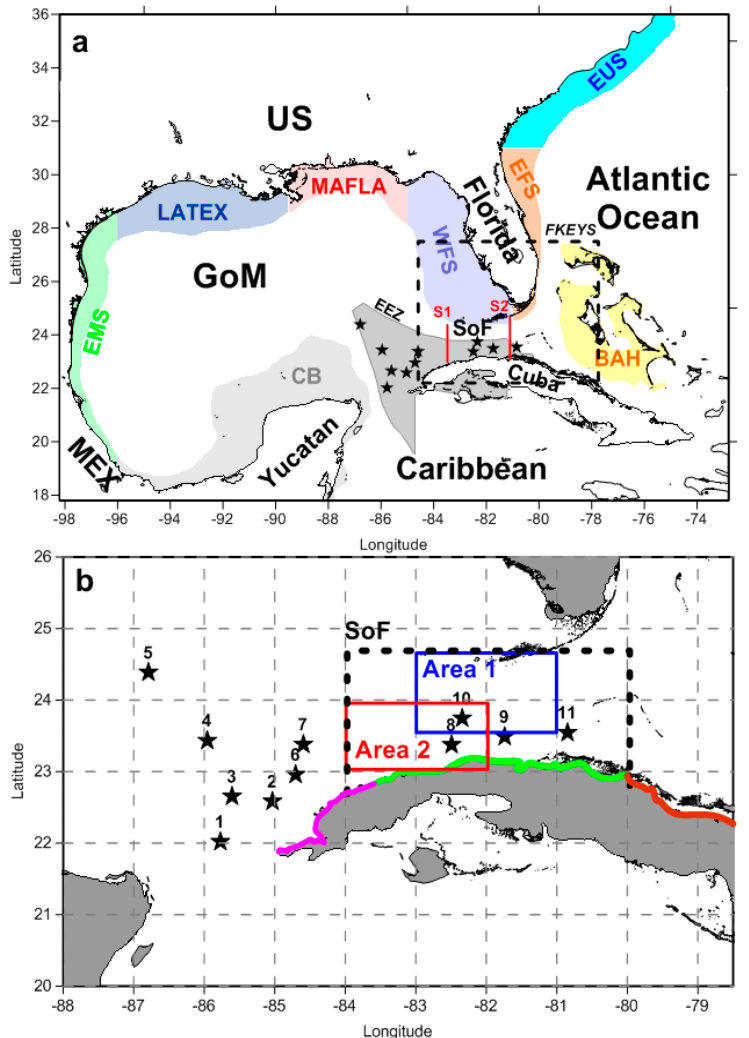
Figure 1. ( a ) The Gulf of Mexico (GoM) domain of the GoM-HYCOM 1/50 simulations with the main geographical areas (United States: US; Mexico: MEX; Gulf of Mexico: GoM; Straits of Florida: SoF; Florida; Yucatan; Cuba), the adjacent seas (Atlantic Ocean and Caribbean Sea) and the respective major continental shelves (Eastern Mexico Shelf: EMS; Louisiana and Texas Shelf: